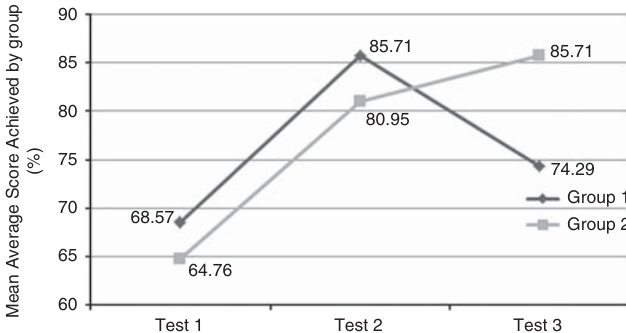
Figure 6. Histograms for the number of correct answers achieved – Test 1-3